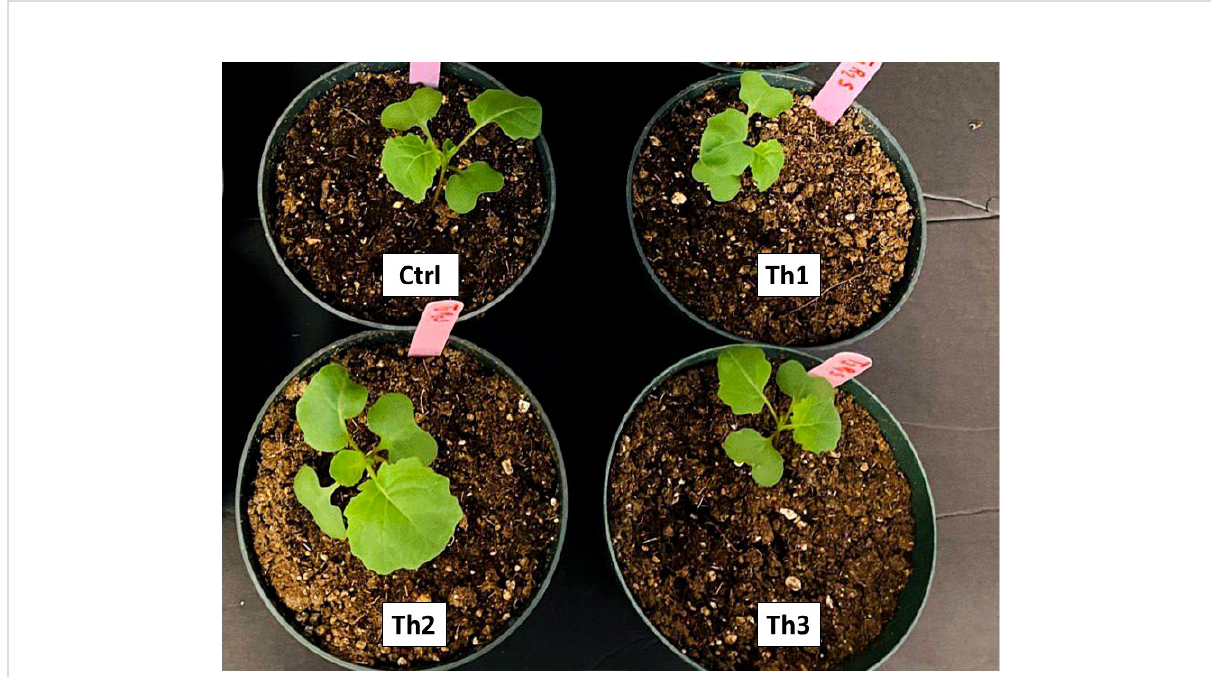
FIGURE 2 3-week-old canola plants grown under optimal conditions. Ctrl: seeds treated with distilled water, Th1: seeds treated with 10 -7 M Th17, Th2: seeds treated with 10 -9 M Th17, Th3: seeds treated with 10 -11 M